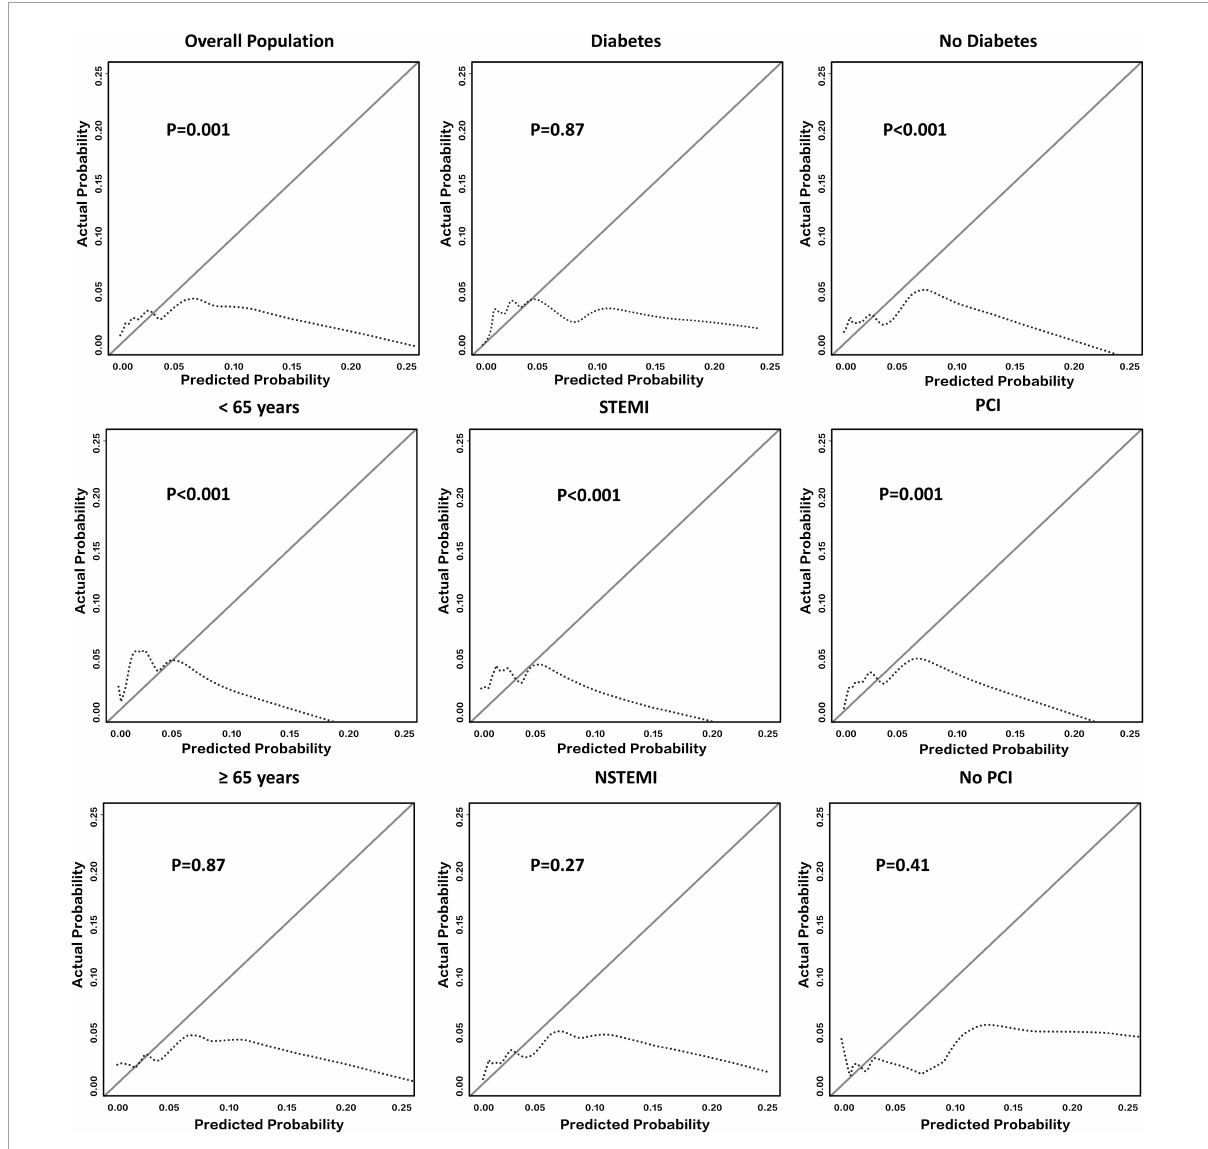
FIGURE2 Calibration of SS in all East Asian patients with AMI and their subgroups. It shows the calibration plot of SS for predicting in-hospital major bleeding among the whole East Asian population with AMI and several representative subgroups. Deviations from ideal calibration represent bias in the predicted probability. The figure indicates that the calibration of SS in the overall population was not acceptable ( p = 0.001). Note that p > 0.05 represents an acceptable calibration ability among a single subgroup. AMI, acute myocardial infarction; NSTEMI, non-ST-segment elevation myocardial infarction; PCI, percutaneous coronary intervention; SS, SWEDEHEART score; STEMI, ST-segment elevation myocardial